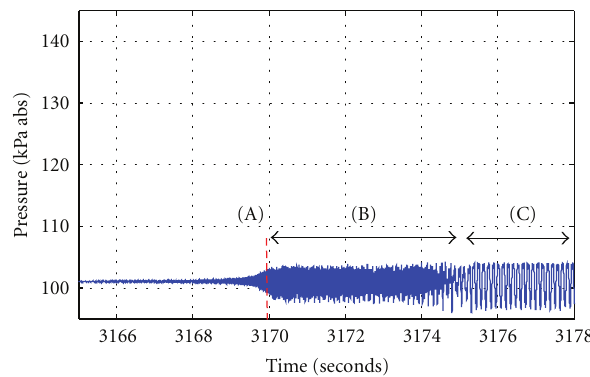
Figure 11: Pressure fluctuations in the inlet during the onset of surge at 16,000 rpm: (A) instability initiation—observed audible sound change, (B) initial pressure fluctuations at a frequency near 21Hz, and (C) pressure fluctuations changed to a lower frequency near 7Hz as throttle valve closed further.